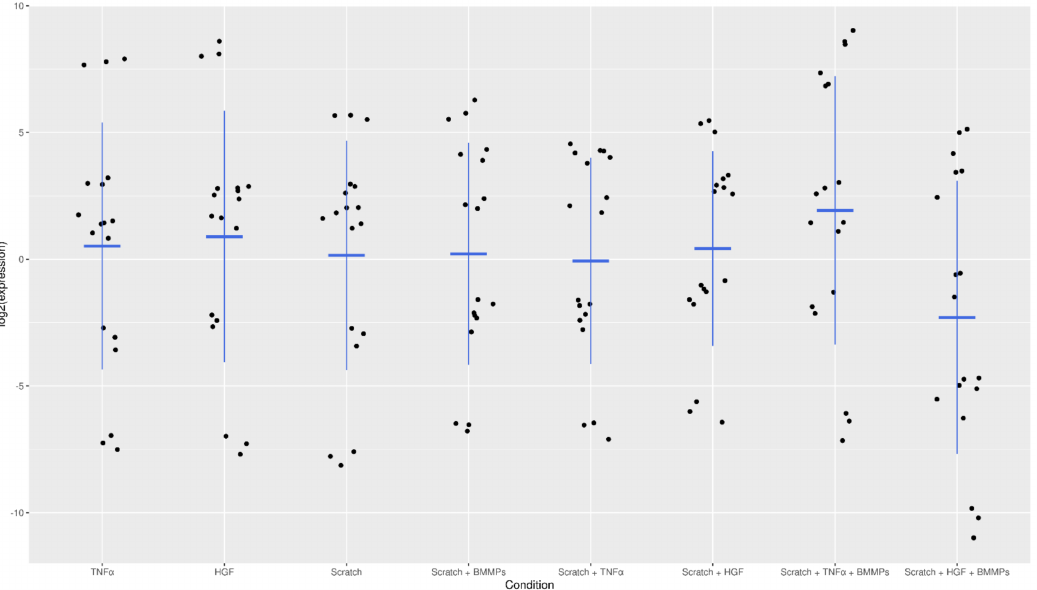
Figure A1. Strip plot of log2 expression of IL-8 and CD73 against the different conditions for the three biological